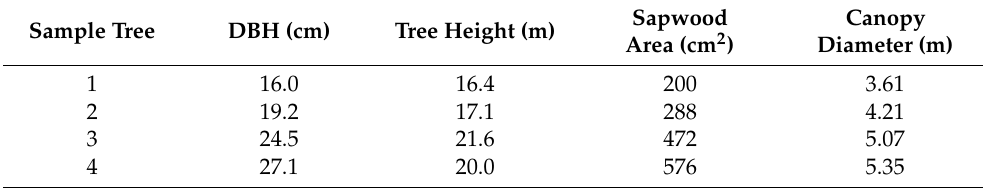
Table 2. Characteristics of sample trees used to monitor sap flow in the sample plot. Sample Tree DBH (cm) Tree Height (m)